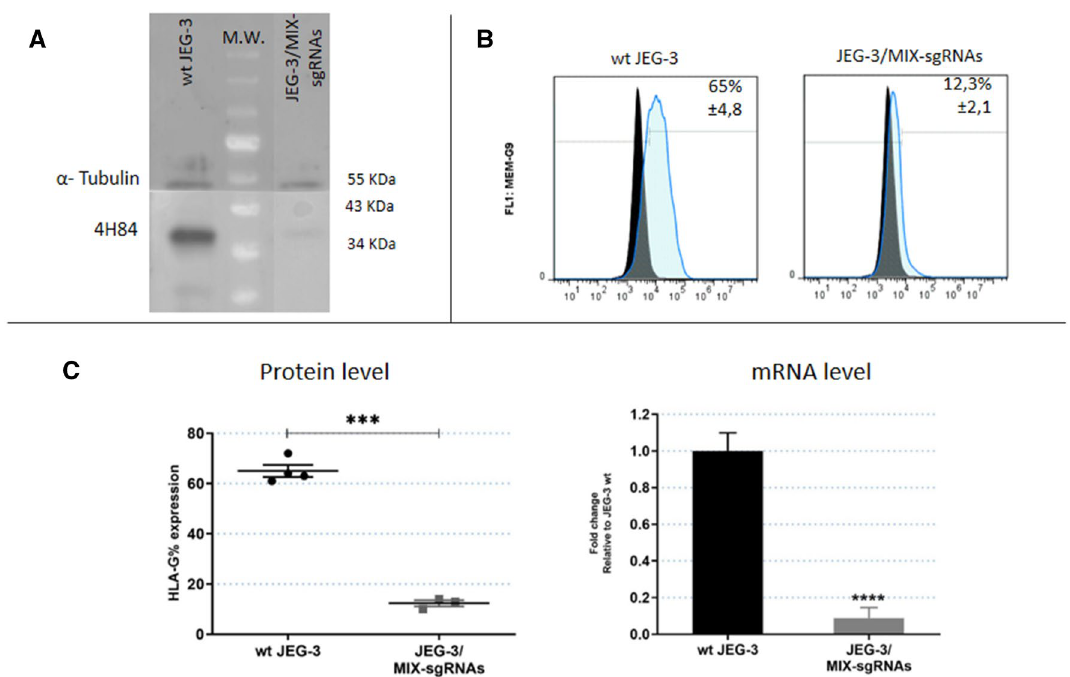
Figure 4. Analysis of JEG-3 edited cells by CRISPR/Cas9 with 4 sgRNAs simultaneously (named MIX-sgRNAs) ( A ) Western Blot analysis of HLA-G expression in JEG-3/MIX-sgRNAs cells (right) and wild type JEG-3 (left). ( B ) Representative histograms of HLA-G measured by flow cytometry. Isotype control is shown in black. ( C ) On the left is shown the protein expression measured by flow cytometry. On the right is shown the HLA-G mRNA expression measured by RT-qPCR. No significant: ns. Significant differences are shown with * ( p <